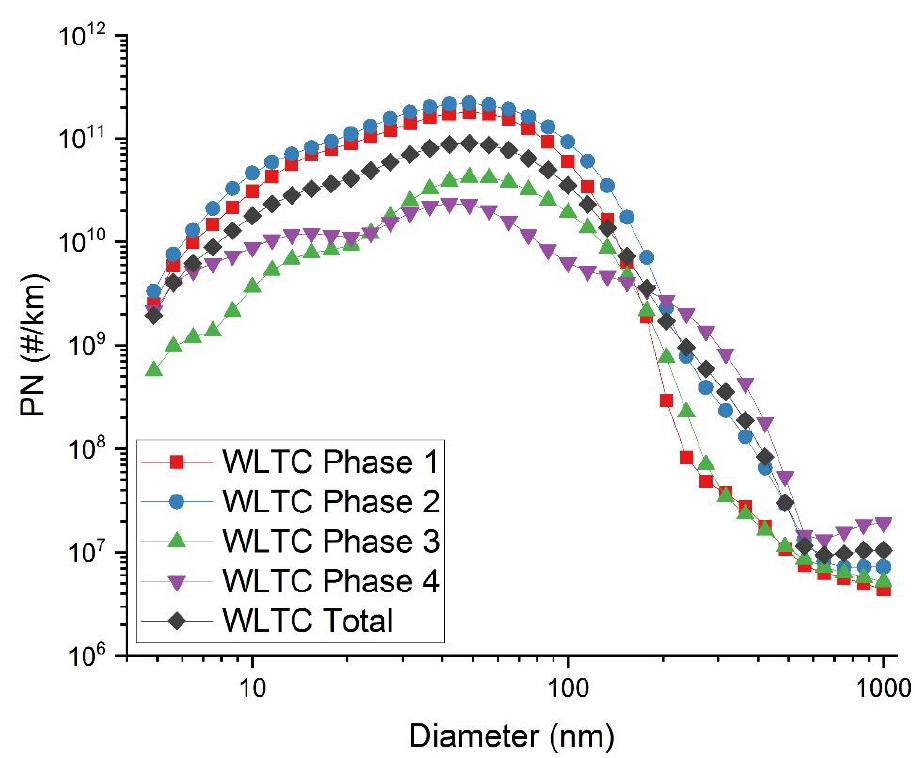
Figure 15. Average size distributed PN emission factors from individual phases and total WLTC cycles.